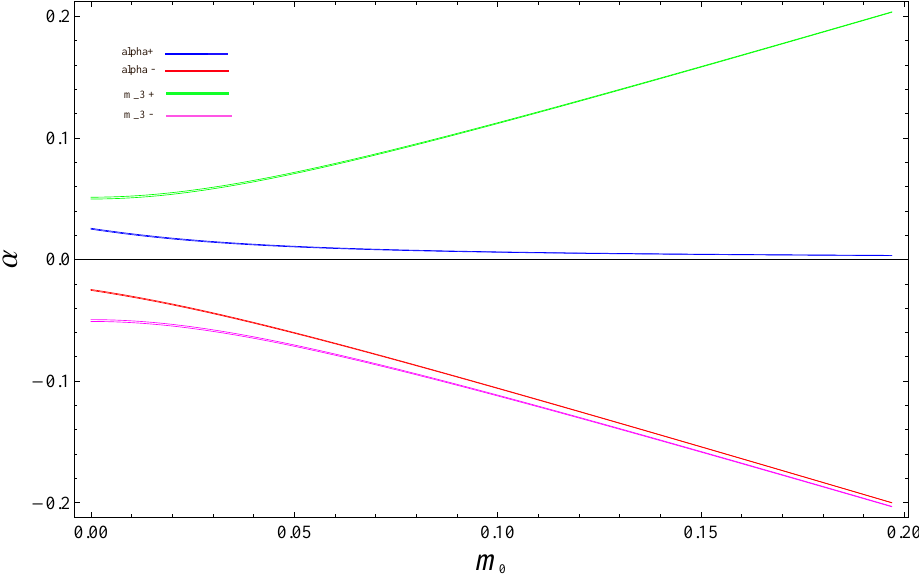
Figure 1. Allowed range of α in ( α , m 0 ) parameter space. Two symmetric spaces are associated to m 3 > 0 and m 3 < 0 which yield two different results for α